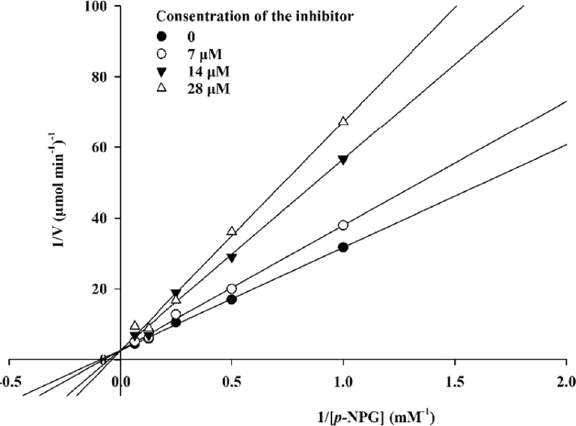
Figure 3. The Lineweaver–Burk plot in the absence and presence of different concentrations of